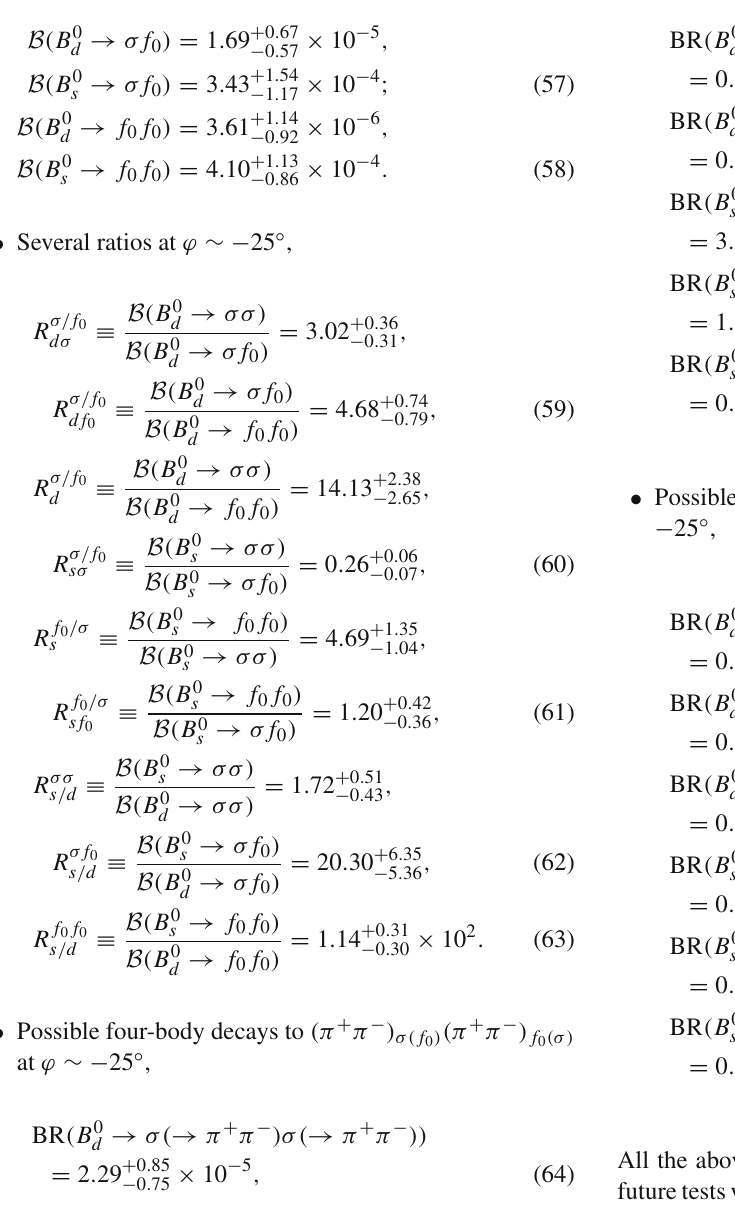
Fig. 2 Dependence of the CP-averaged B 0 blue-dashed line, and the magenta-dotted line correspond to the final states of σσ , σ f 0 , and f 0 f 0 ,